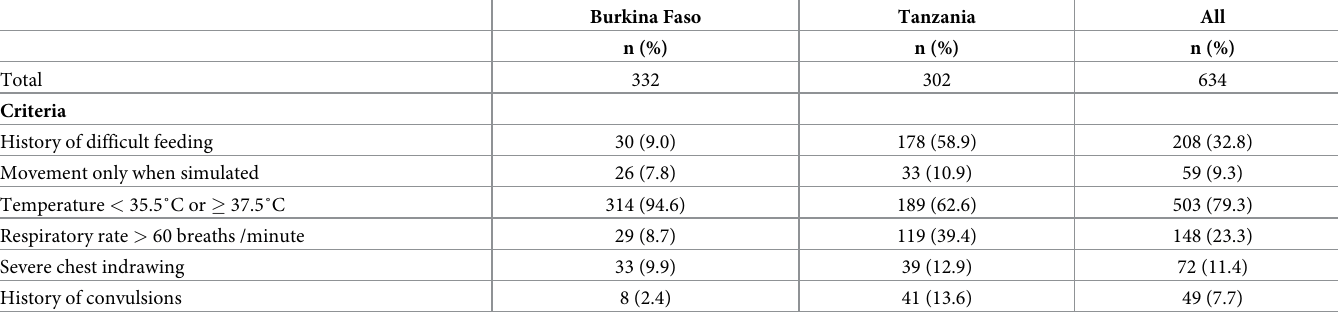
Table 3. Presentation of criteria for clinical suspicion of severe invasive infection at time of presentation at the hospital. Burkina Faso